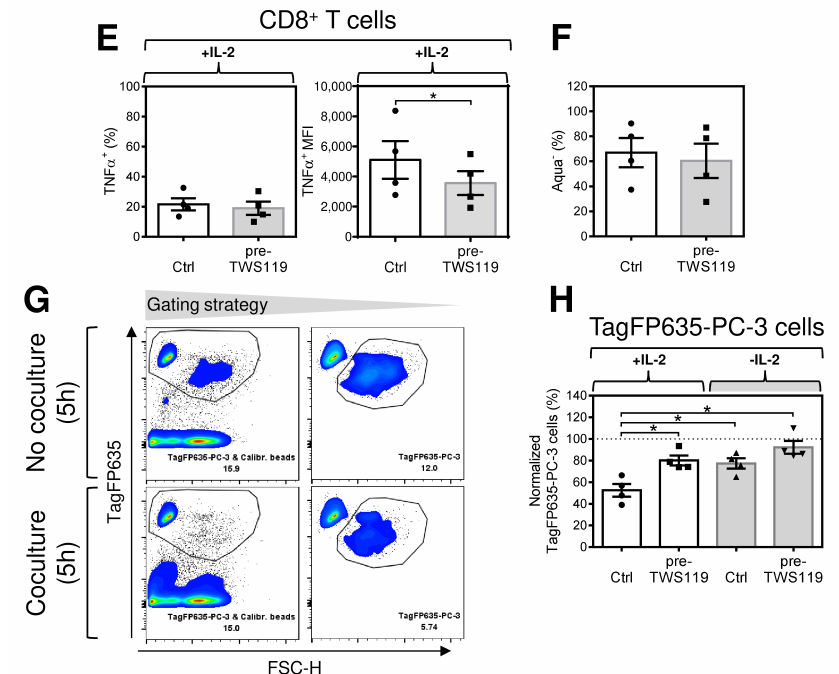
Figure 4. Galectin-9 inhibits the immediate response of expanded CD8 + T cells after stimulation with antigen. Acute conditioning of the expanded CD8 + T cells with the GSK-3 β inhibitor TWS119 prior to antigen rechallenge decreases Tim-3 expression and diminishes the robustness of the immediate response of expanded CD8 + T cells after stimulation with antigen. ( A , B ) The impact of galectin-9 on expanded T cells. The 14-day-expanded lymphocytes were reconstituted in the presence of IL-2 as in Figure 1. The cells were (Gal-9), or were not (Ctrl), treated with recombinant galectin-9 (20 µ g / mL) for 30 min, and then stimulated with PC-3 cells as in Figure 1. The cells were analyzed by flow cytometry using the gating strategy in Figure 1B. ( A ) The proportion of the IFN γ + population and its intensity of staining (MFI) of CD8 + T cells. ( B ) The proportion of the TNF α + population and its intensity of staining (MFI) of CD8 + T cells. ( C , D ) The impact of the GSK-3 β inhibitor TWS119 on surface expression of Tim-3 and viability of expanded CD8 + T cells. The 14-day-expanded lymphocytes were reconstituted and cultured for 18–24 h with IL-2 (80 IU / mL). The cells were pelleted, resuspended in IL-2-containing (80 IU / mL), or not containing, medium supplemented with TWS119 (7 µ M), and cultured for 18–24 h. ( C ) The intensity of Tim-3 staining (MFI) of expanded CD8 + T cells. ( D ) The proportions of viable (DAPI − ) cells and the proportions of their annexin V + populations. The gating strategy for annexin V staining is shown in Figure S2D. ( E , F ) The impact of the GSK-3 β inhibitor TWS119 on the robustness of the immediate response of expanded CD8 + T cells after stimulation with antigen. The 14-day-expanded lymphocytes were reconstituted and treated as in ( C , D ) and then stimulated with PC-3 cells as in Figure 1. ( E ) The proportion of the TNF α + population (left panel) and its intensity of staining (MFI) (right panel) of CD8 + T cells. ( F ) The proportion of viable (Aqua − ) cells. ( G , H ) The cytotoxic impact of the 14-day-expanded lymphocytes on fluorescent TagFP635-PC-3 cells. The 14-day-expanded lymphocytes were reconstituted and treated as in ( C , D ) and then stimulated (cocultured) with TagFP635-PC-3 cells as in Figure 1. The proportions of TagFP635-PC-3 cells in the cultures were determined by flow cytometry. ( G ) The gating strategy used to analyze flow cytometry data. ( H ) Normalized proportions of TagFP635-PC-3 cells after coculture with lymphocytes. The proportions were normalized to TagFP635-PC-3 cells not cocultured with lymphocytes (100 %). In ( A – H ), bars represent the mean of values determined in each group. In ( A – C ) (left panel), and ( D – F ), the significance of di ff erences between the group of cells is indicated (* p < 0.05, ( A , B , D ): n = 3 donors, ( C (left panel) and E , F ): n = 4 donors, paired 2-tailed Student’s t test). In ( C ) (right panel) and ( H ), the significance of di ff erences among the group of cells is indicated (* p < 0.05, ( C ) (right panel): n = 3 donors, ( H ): n = 4 donors, 1-way ANOVA with the Tukey